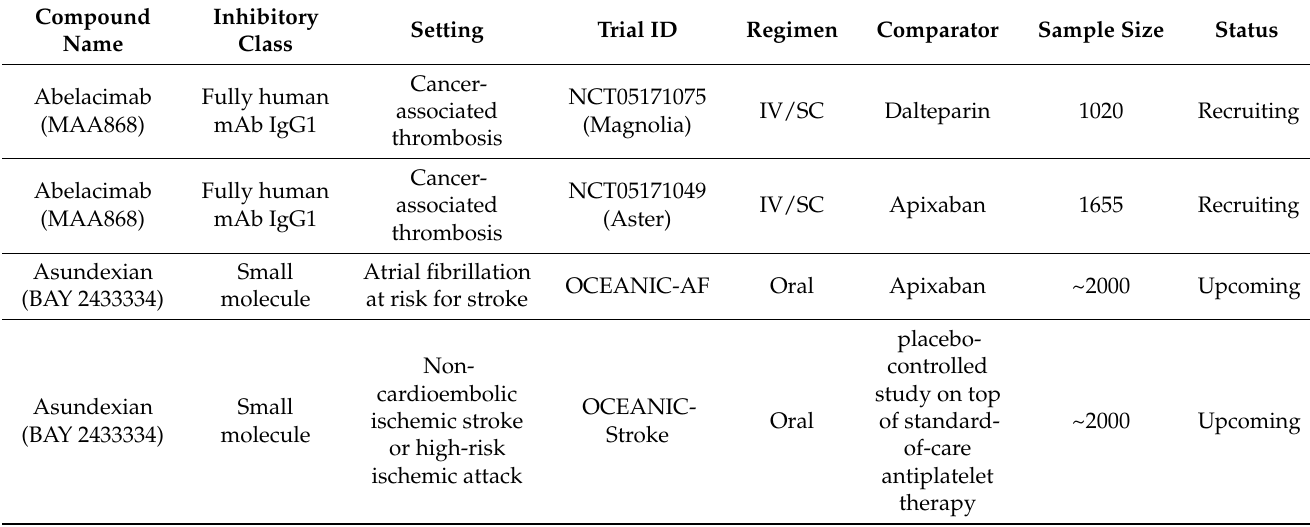
Table 11. Phase III ongoing trials assessing anti-FXI drugs in the prevention of